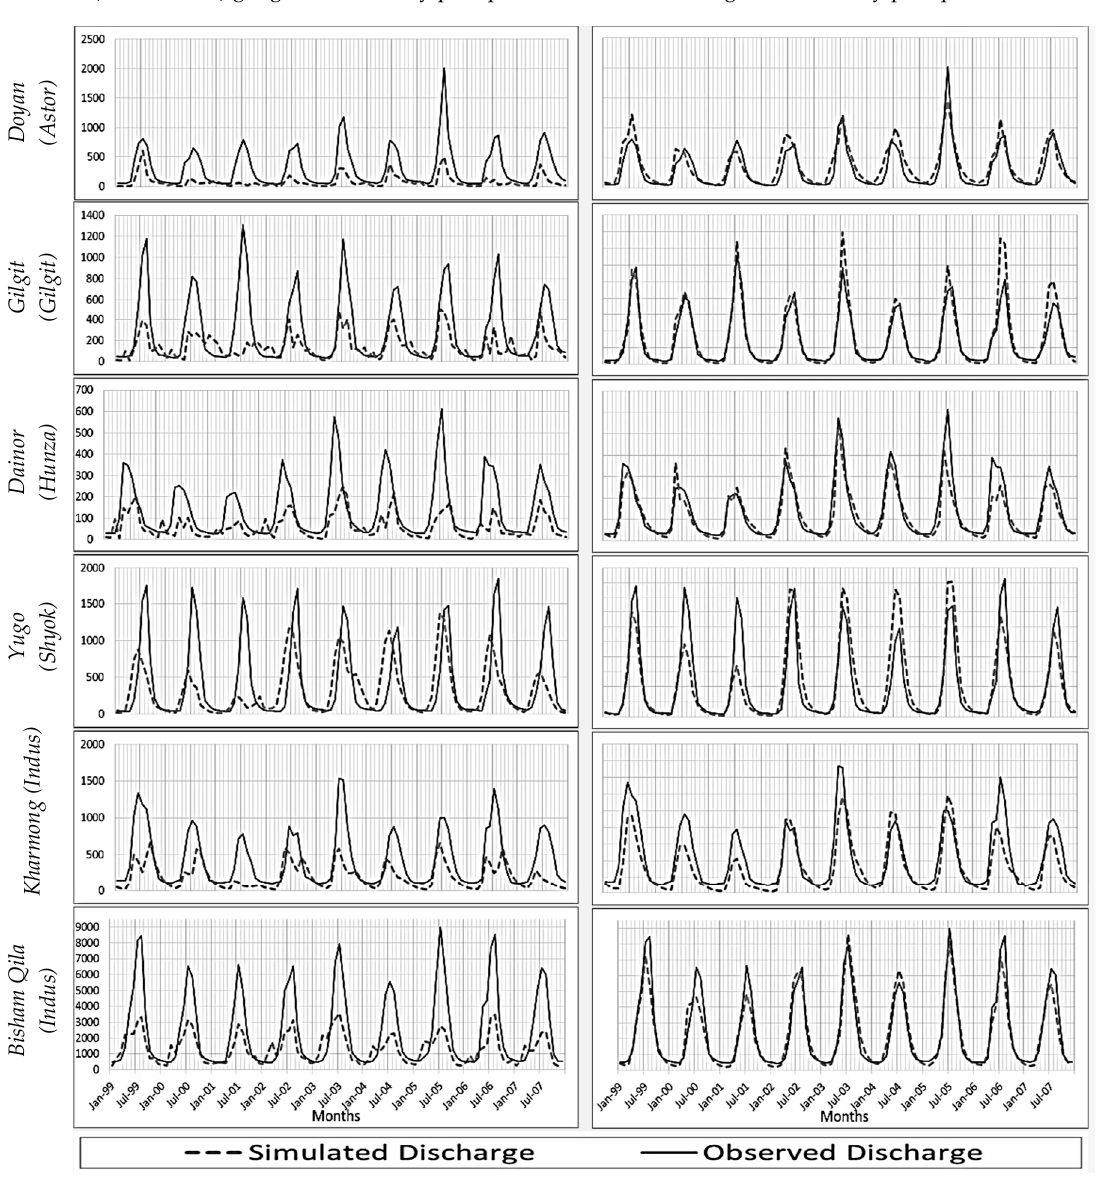
Figure 4. Comparison of SWAT-modelled flows with observed flows at different catchment outlets in the UIB when forcing the model with observed gauge station ( left column) and corrected, regionalized ( right column) precipitation.